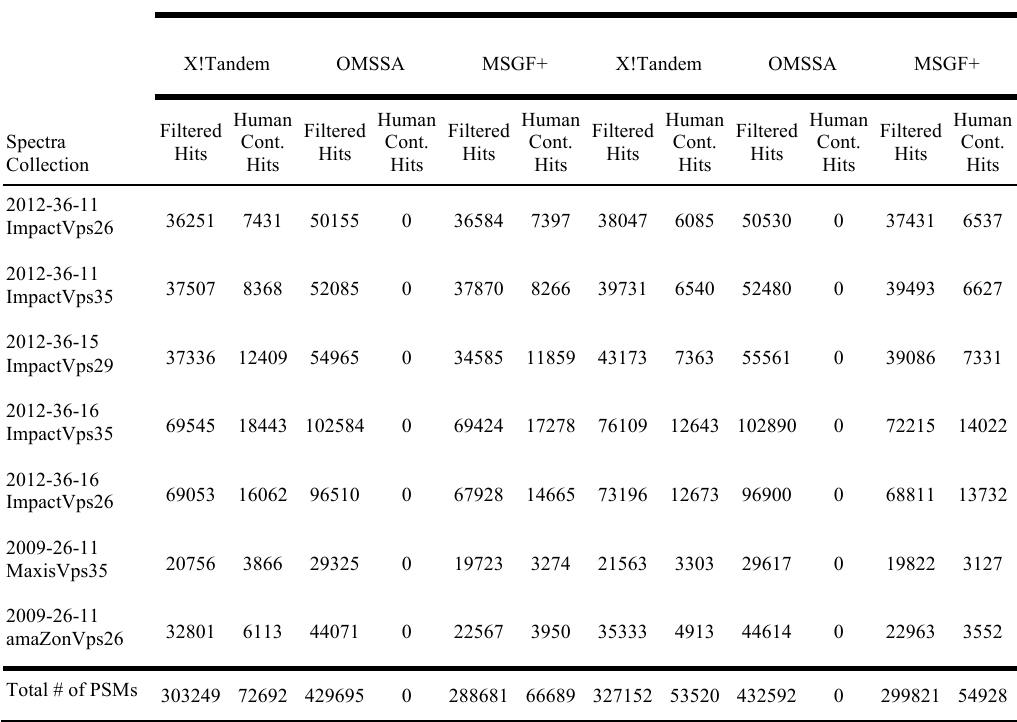
Table 2: Number of target and decoy peptide-spectrum matches obtained from X!Tandem, OMSSA, and MSGF+ using the toxoplasma genome and human gene models are listed on a per collection basis from